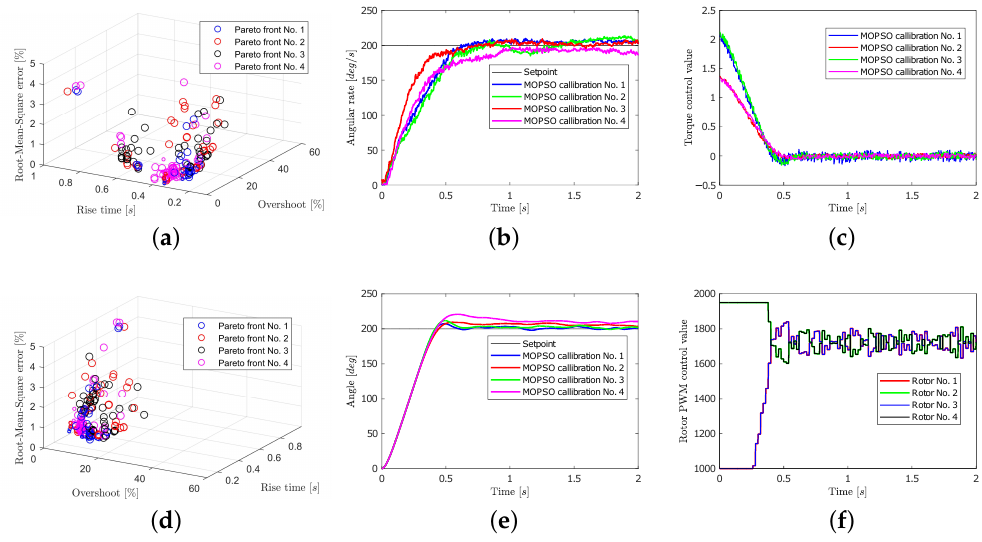
Figure 10. Results obtained for the yaw axis. ( a ) Pareto front (the bigger particles represent the ones without oscillation hazard). ( b ) Experimental step response. ( c ) Torque control values. ( d ) Pareto front in a different perspective. ( e ) Simulation step response. ( f ) PWM control value (calibration number 1).